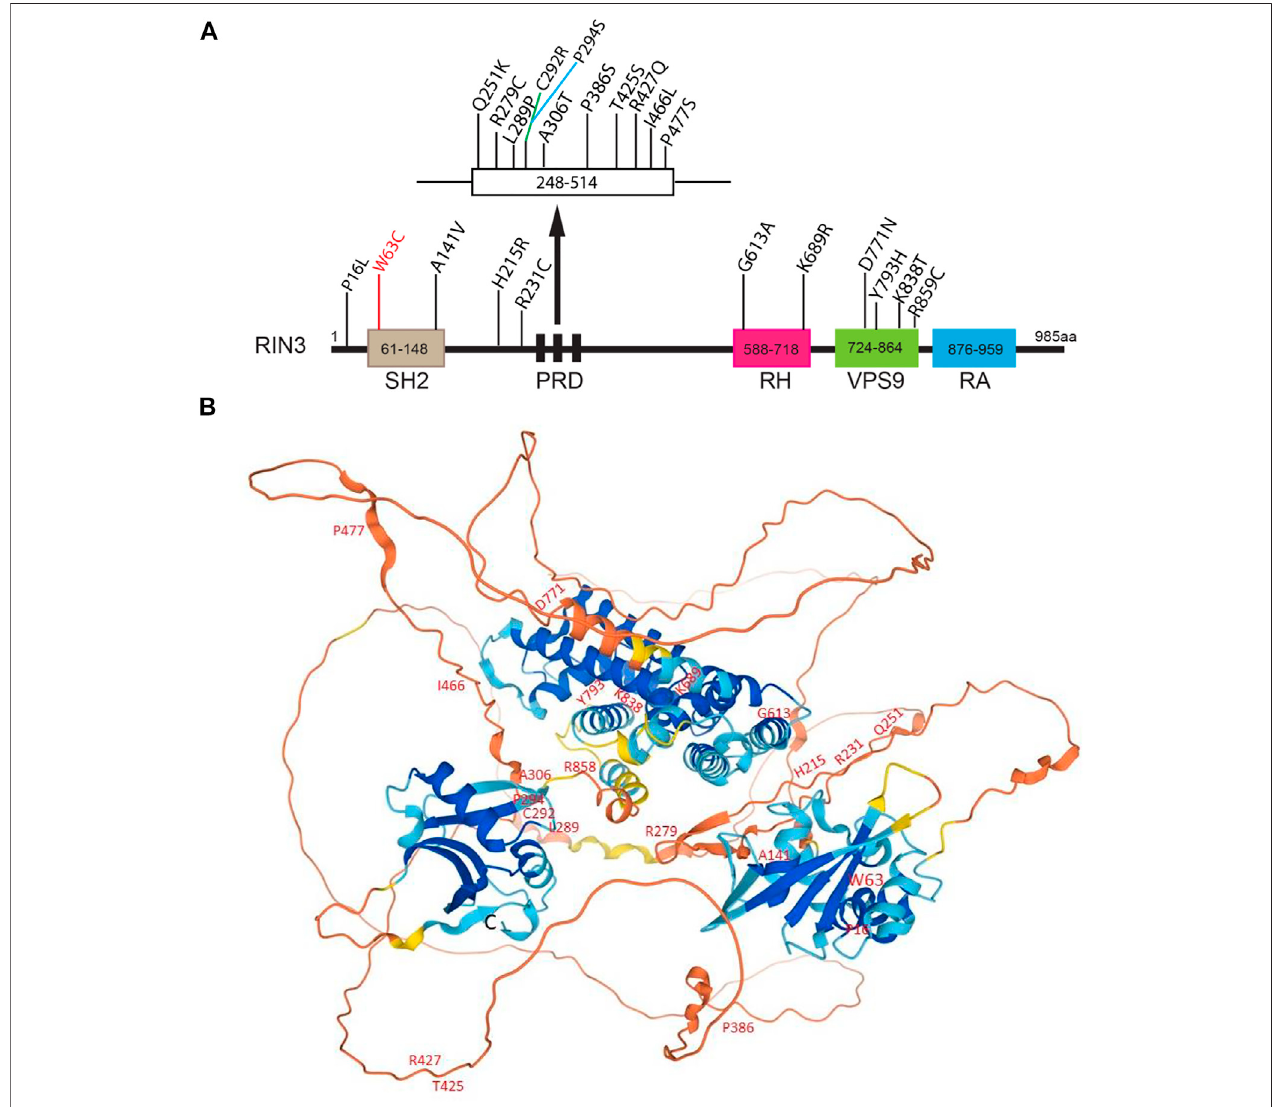
FIGURE 4 | Disease-associated variants/mutations and predicted structure of human RIN3. (A) . A linear presentation of all known mutation sites in the various domains of RIN3. Missense mutations in RIN3 have been discovered thus far, all are associated with Page ’ s Disease of the Bone; except that: 1) W63C is linked with sporadicEOAD;2)R279CisassociatedwithCOPDandP386S. (B) .PredictedstructureofhumanRIN3byAlphaFold(https://alphafold.ebi.ac.uk/entry/Q8TB24).Allthe known mutations that have been identi fi ed are marked. For a detailed prediction of RIN3 3D structure, see supplemental movie.